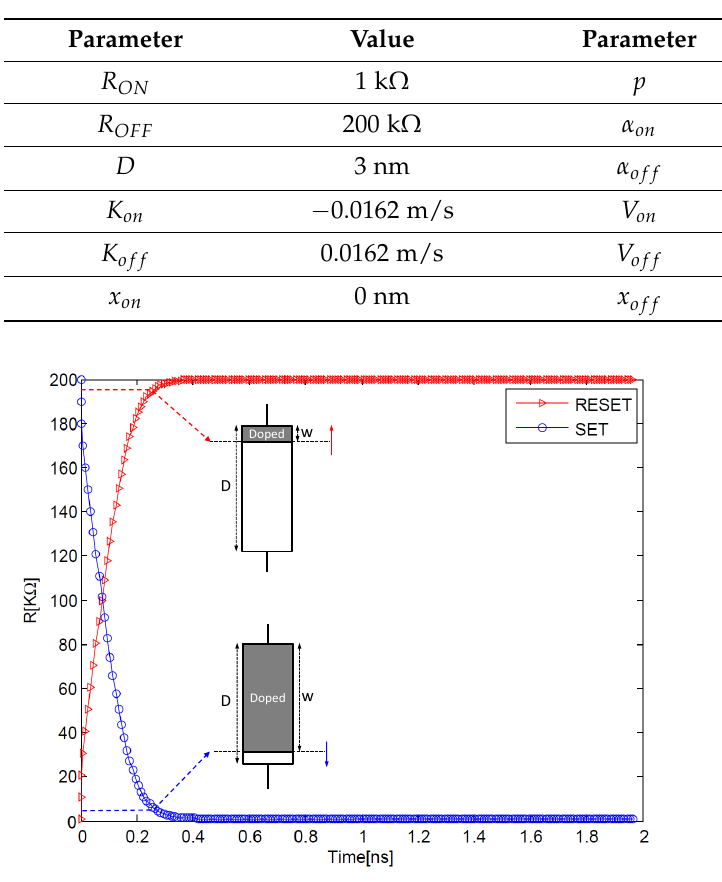
Table 2. VTEAM fitting parameters for the device in [35].